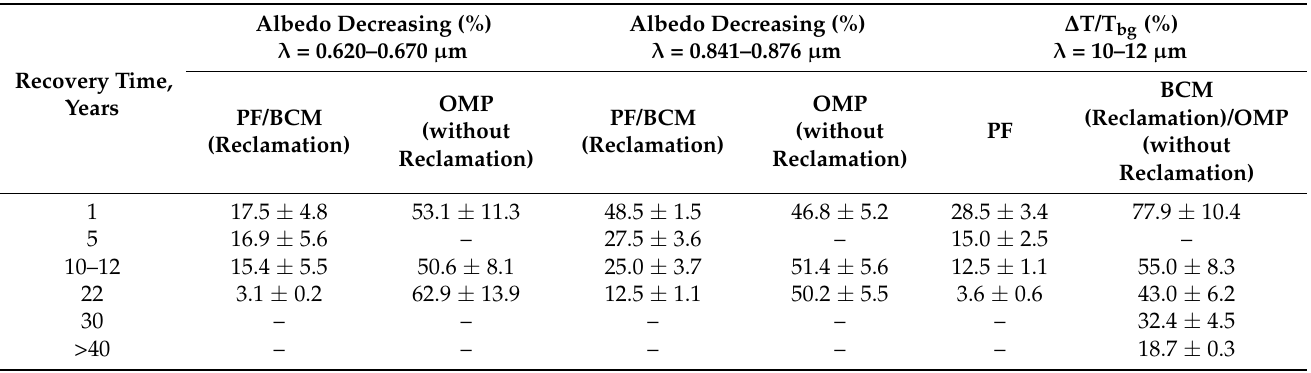
Table 4. Changes in the spectral characteristics of disturbed areas in % to background values for the options PF, BUR (reclamation), and OMP (without reclamation). Mean value for July ± SD, p < 0.05.